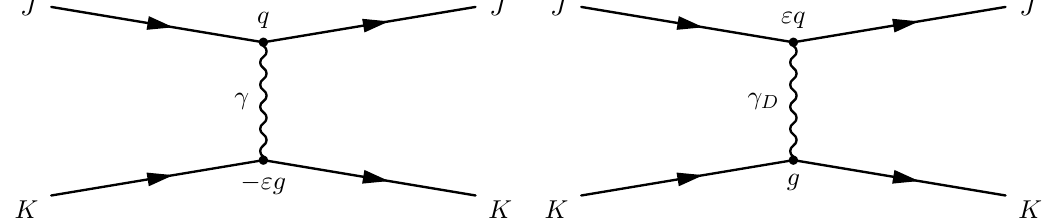
Figure 3 . The t -channel scattering of an electrically charged particle and a bound magnetic monopole. The two diagrams from the exchange of the visible photon and the dark photon give amplitudes with opposite